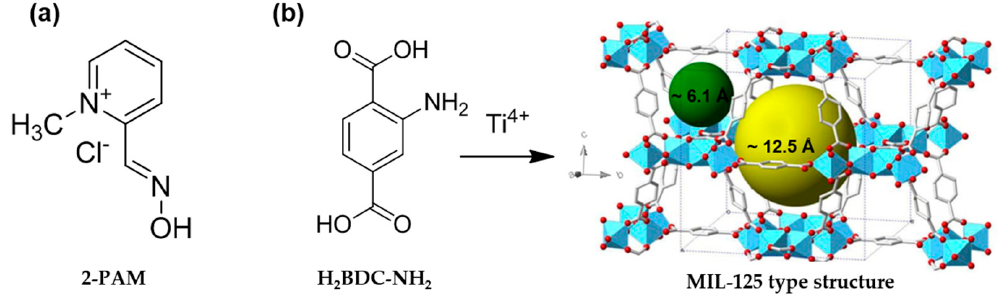
Figure 1. Representation of the structure of ( a ) 2-pyridinium aldoxime methyl chloride (2-PAM) and ( b ) reaction scheme for the preparation of MIL-125-NH 2 (MIL = Material of Institut Lavoisier), highlighting its cavities of 6.1 (green sphere) and 12.5 Å (yellow sphere) from 2-aminoterephthalic acid (H 2 BDC-NH 2 ) and Ti 4+ . Titanium polyhedra, oxygen and carbon are represented in blue, red and clear grey, respectively. Hydrogen atoms were omitted for the sake of clarity.